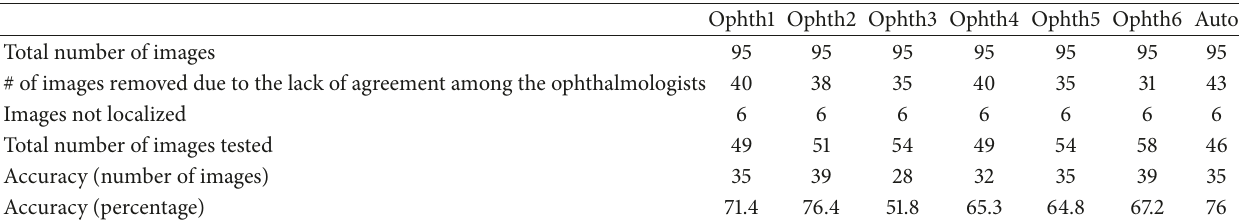
Table 3: The HCDR results for Magrabi images